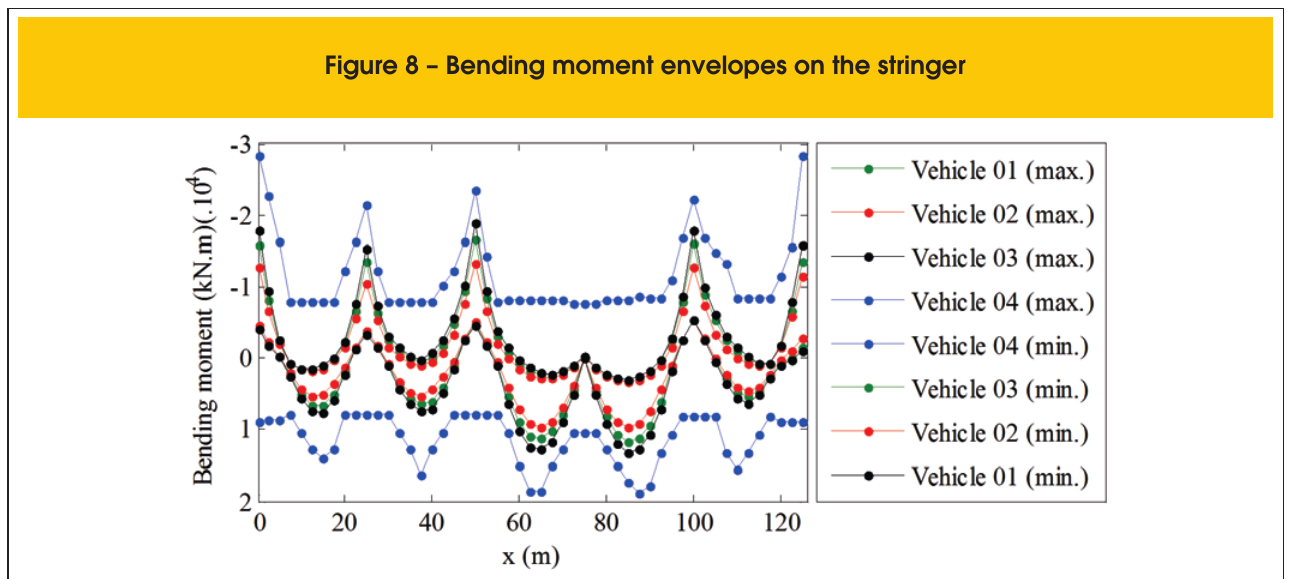
Figure 8 – Bending moment envelopes on the